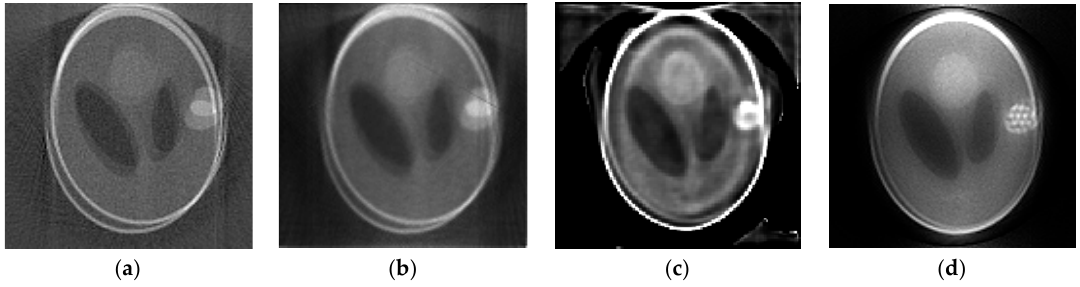
Figure 5. Comparison of the 128th slice of 3D reconstructed images for large motion: ( a ) Image reconstructed by OSEM; ( b ) image reconstructed by OSEM-BD; ( c ) image reconstructed by RL-OSEM; ( d ) image reconstructed by the proposed method. Table 2. Evaluation of motion artifact reduction performance on Shepp–Logan phantom with large motion.